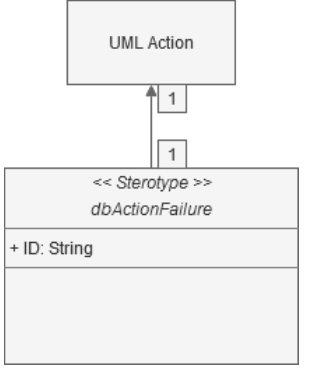
Figure 5. Risk-management Papyrus profile.